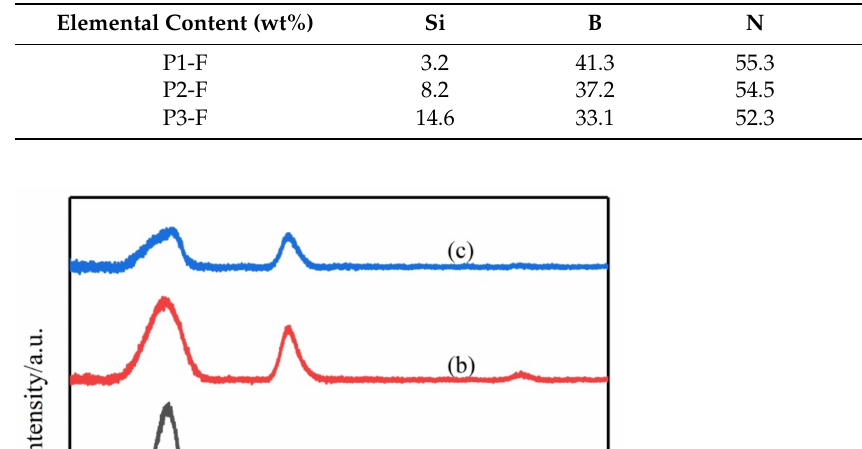
Table 3. Elemental content of BN/Si 3 N 4 composite fibers.